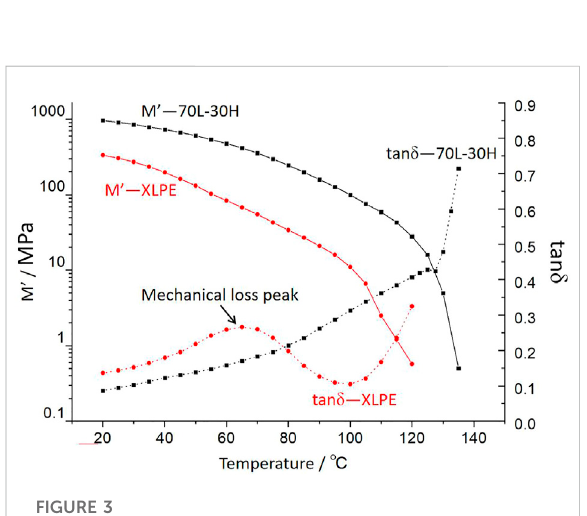
FIGURE 3 Temperature spectrum for DMA of 70L – 30H and XLPE.